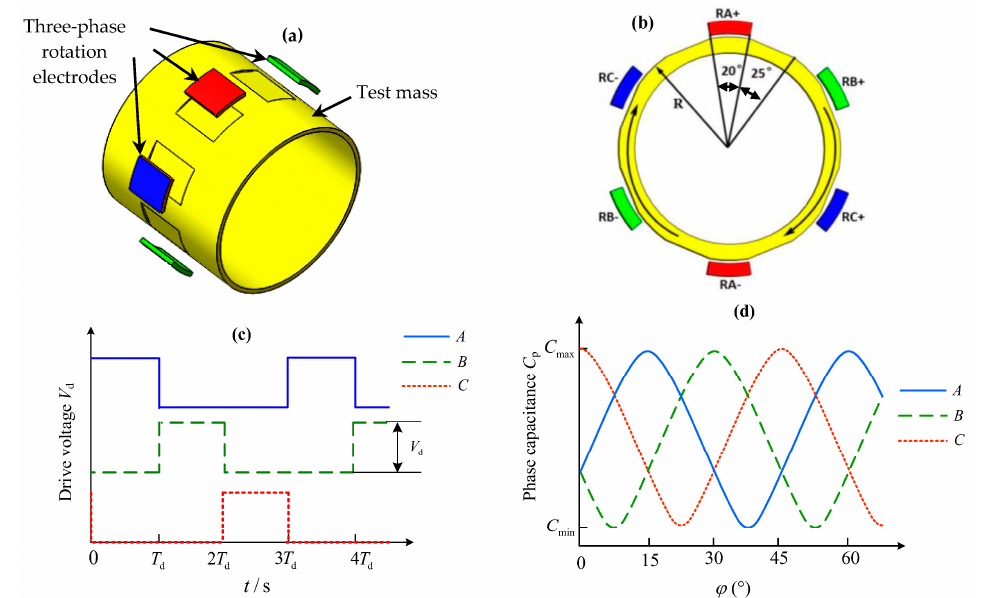
Figure 8. Three-phase variable-capacitance motor: ( a ) Stator electrodes and test mass (rotor); ( b ) Layout of the 6-electrode stator and 8-pole rotor; ( c ) Three-phase excitation voltages and ( d ) Three-phase stator-rotor capacitances as a function of the mechanical rotation angle.